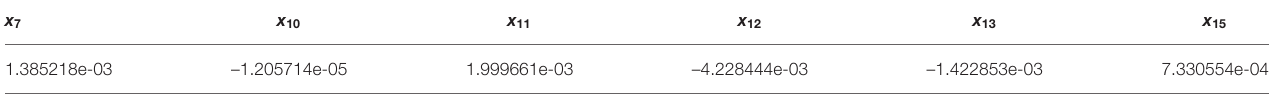
TABLE 2 | Nonzero regression coefficient of Lasso.